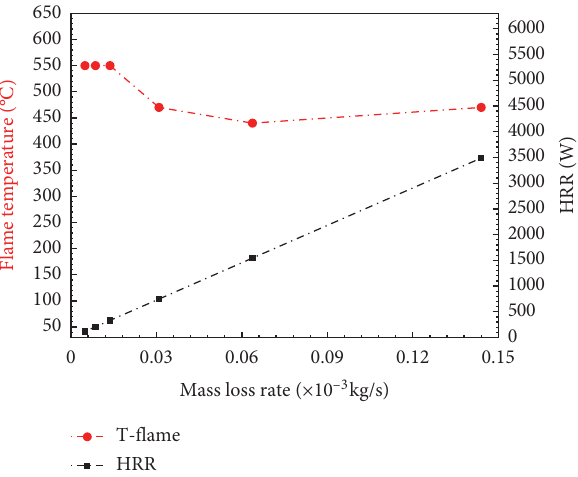
Figure 11: Variation of the flame temperature and heat release rate according to the mass loss rate: case of confined tests.